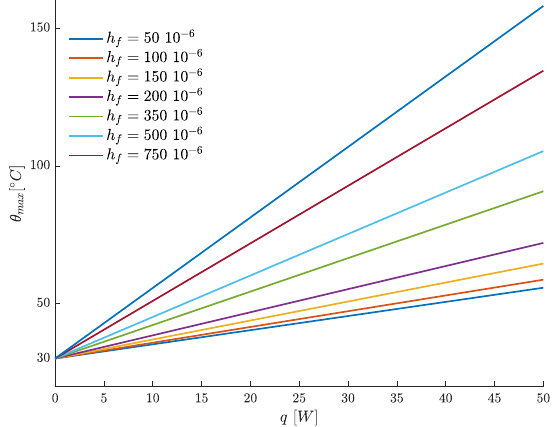
Figure 21. Maximum temperature at the base of the microprocessor for different values of (cid:20) W (cid:21) h f ◦ Cmm 2